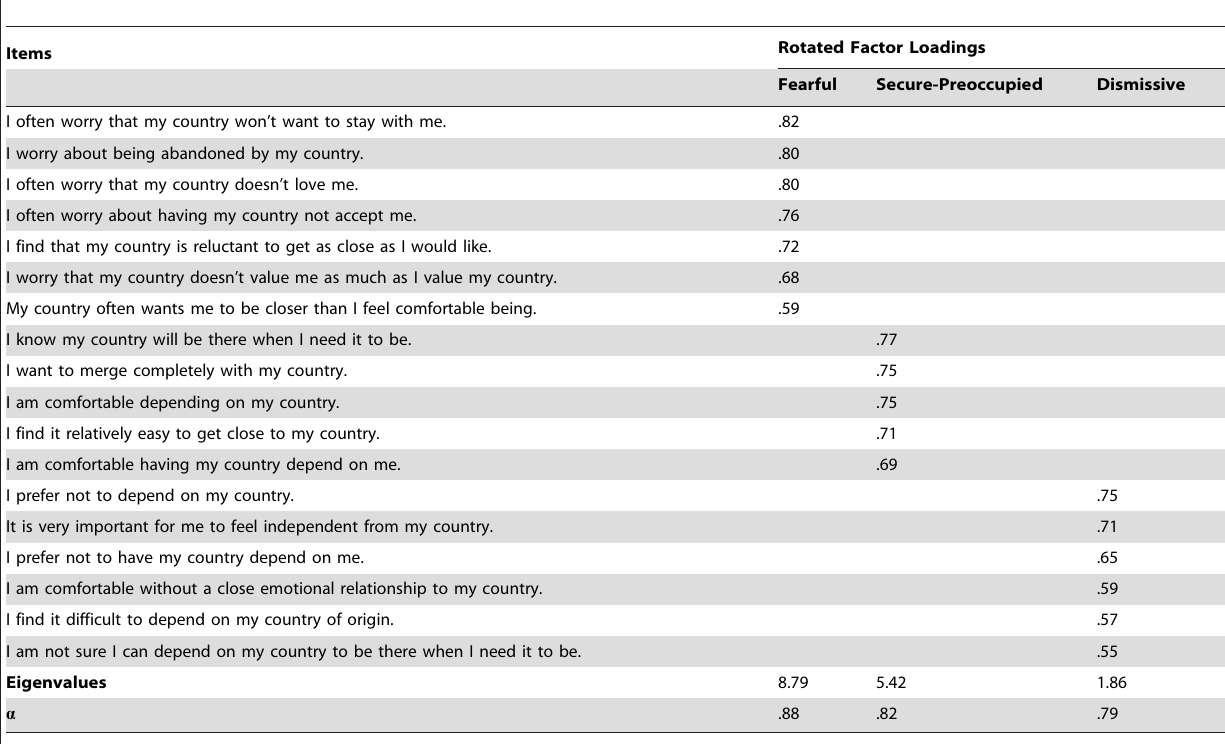
Table 1. Summary of Exploratory Factor Analysis Results of the Structure Matrix for the Country Attachment Questionnaire with Retained Factors ( N